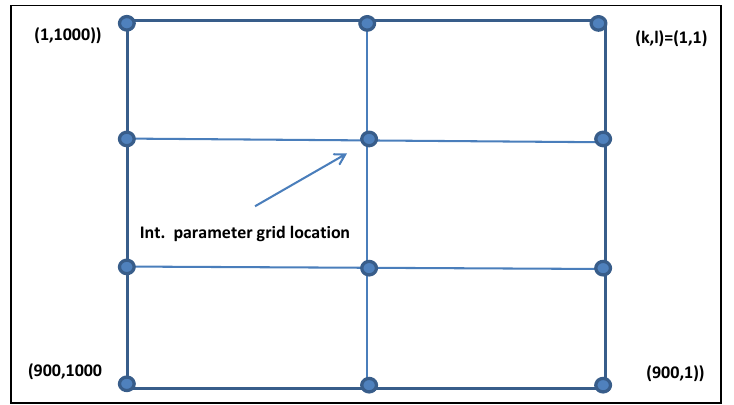
Figure 19. An example of an Interpolation Parameter